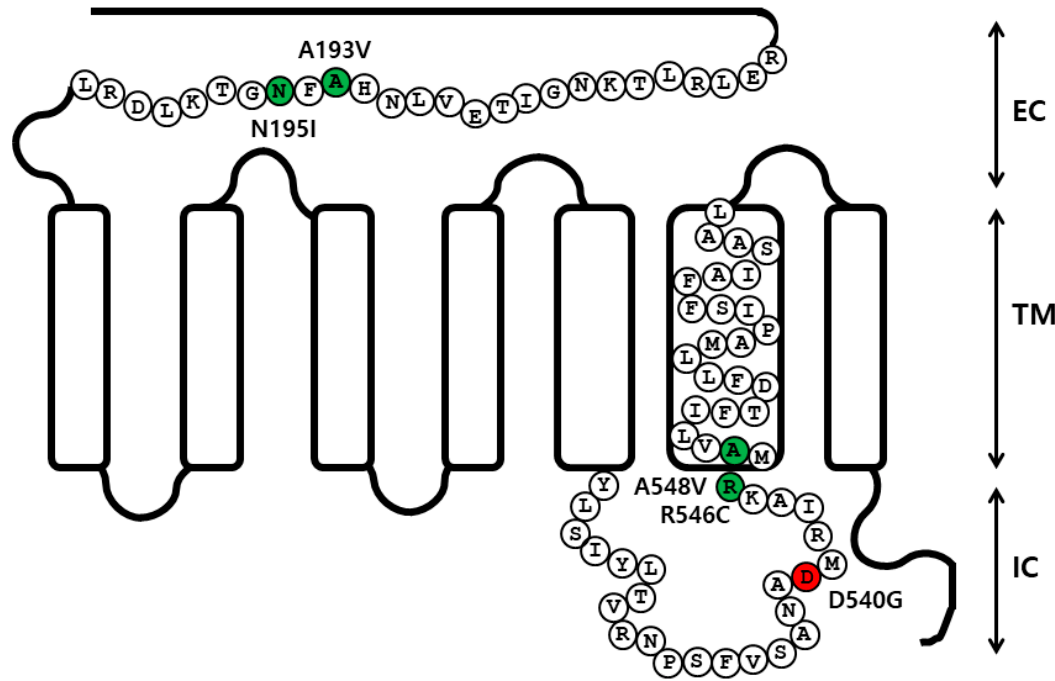
Figure 1. Schematic representation of the structure of eelFSHR. The locations of the constitutive activating mutation (D540G) and the four inactivating mutations (A193V, N195I, R546C, and A548V) are indicated. The red circle indicates the constitutively activating mutation and the green circles indicate inactivating mutations. EC, extracellular domain; TM, transmembrane domain; IC, intracellular domain.